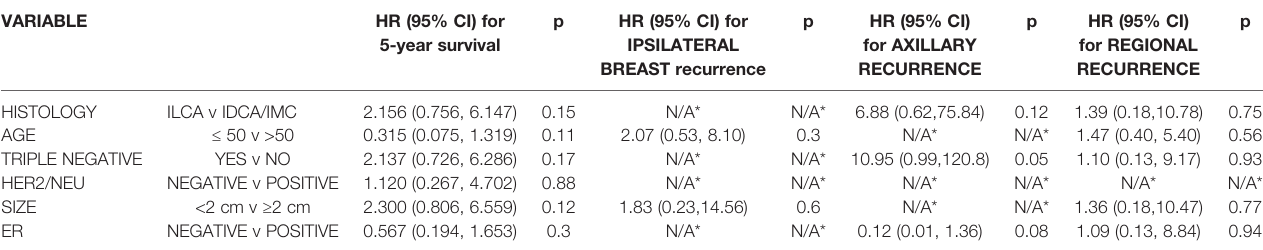
TABLE 3 | Univariate analysis.